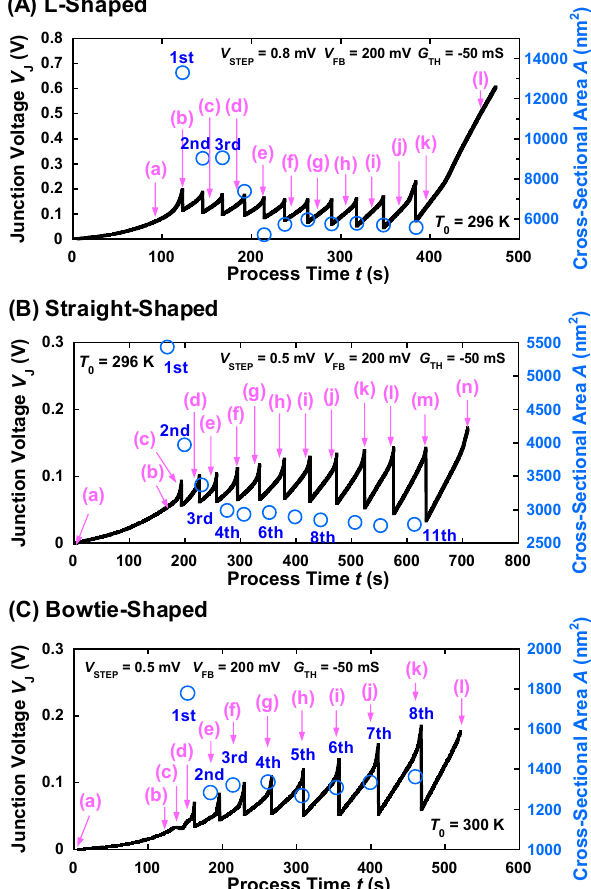
Figure 3. Time evolution of the V J – A characteristics of the ( A ) L-shaped, ( B ) straight-shaped, and ( C ) bowtie-shaped nanowires during feedback-controlled electromigration (FCE).